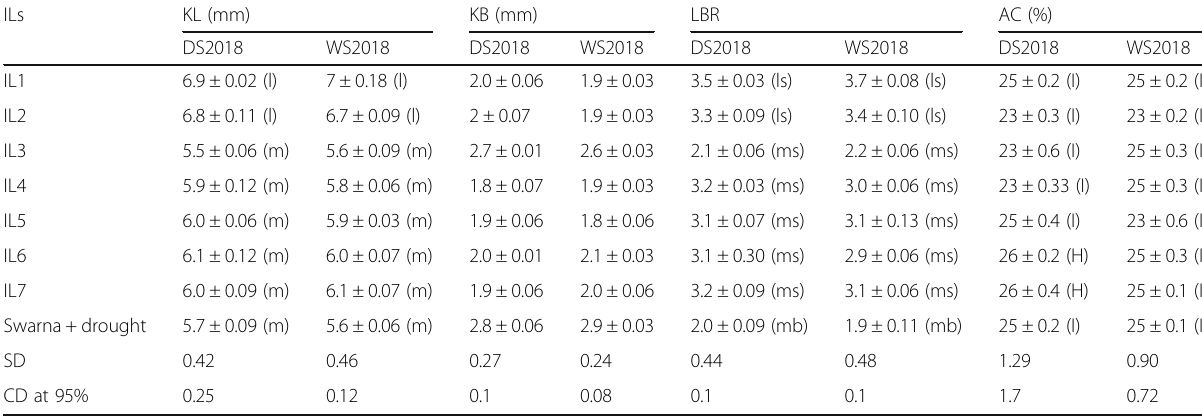
Table 4 Evaluation of grain quality traits of selected introgression lines during DS2018 and WS2018 ILs